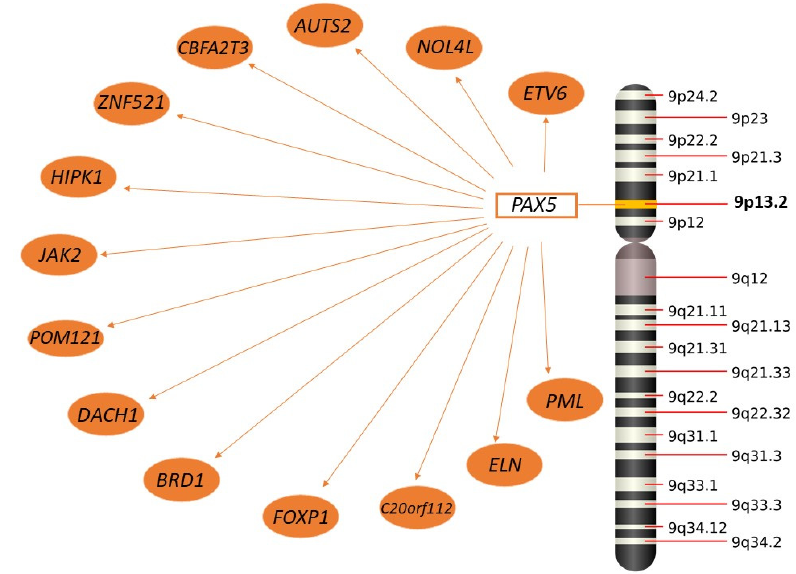
Figure 2. PAX5 partner genes.